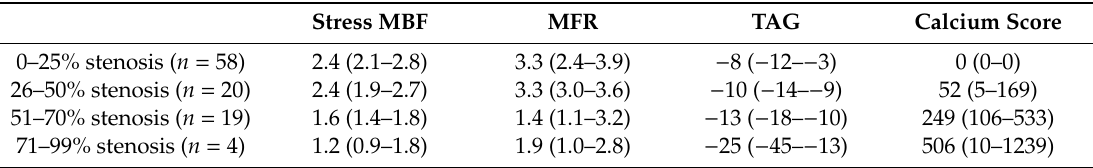
Table 2. Perfusion parameters, transluminal attenuation gradient (TAG) and calcium score along di ff erent stenosis